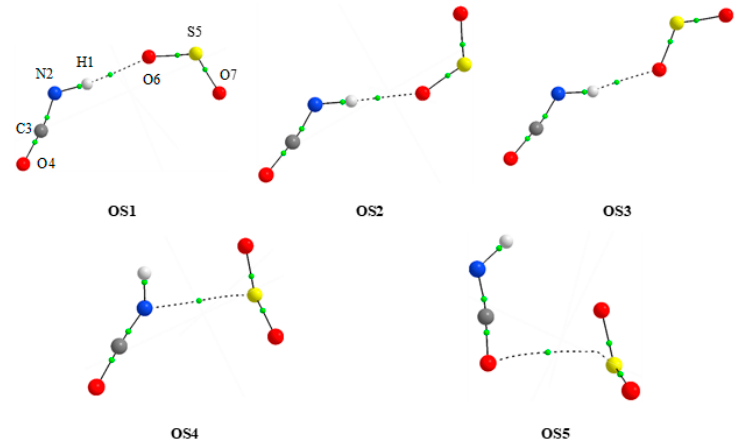
Figure 1. The MP2 optimized structures of the 1:1 complexes of HNCO with SO 2 . Table 1. Interatomic distances (Å), angles (degree) and electron density parameters of the intermolecular bond critical points (au) of the HNCO complexes with SO 2 (1:1) computed at the MP2/6-311++G(3df,3pd) level.